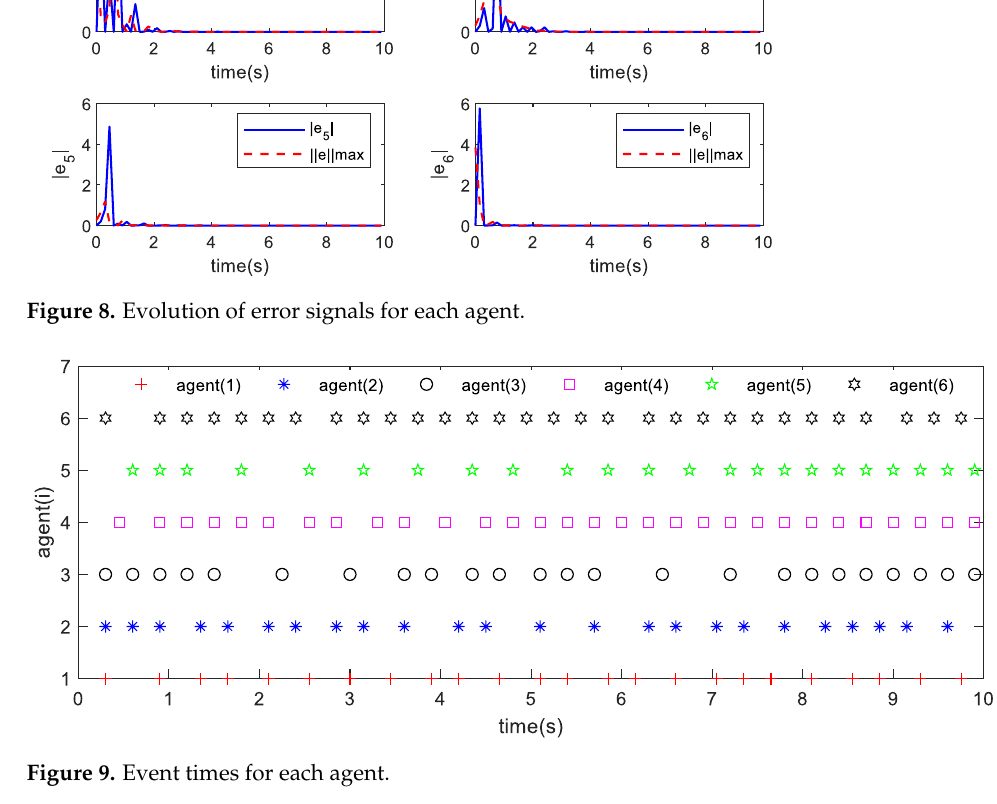
Figure 9. Event times for each agent.